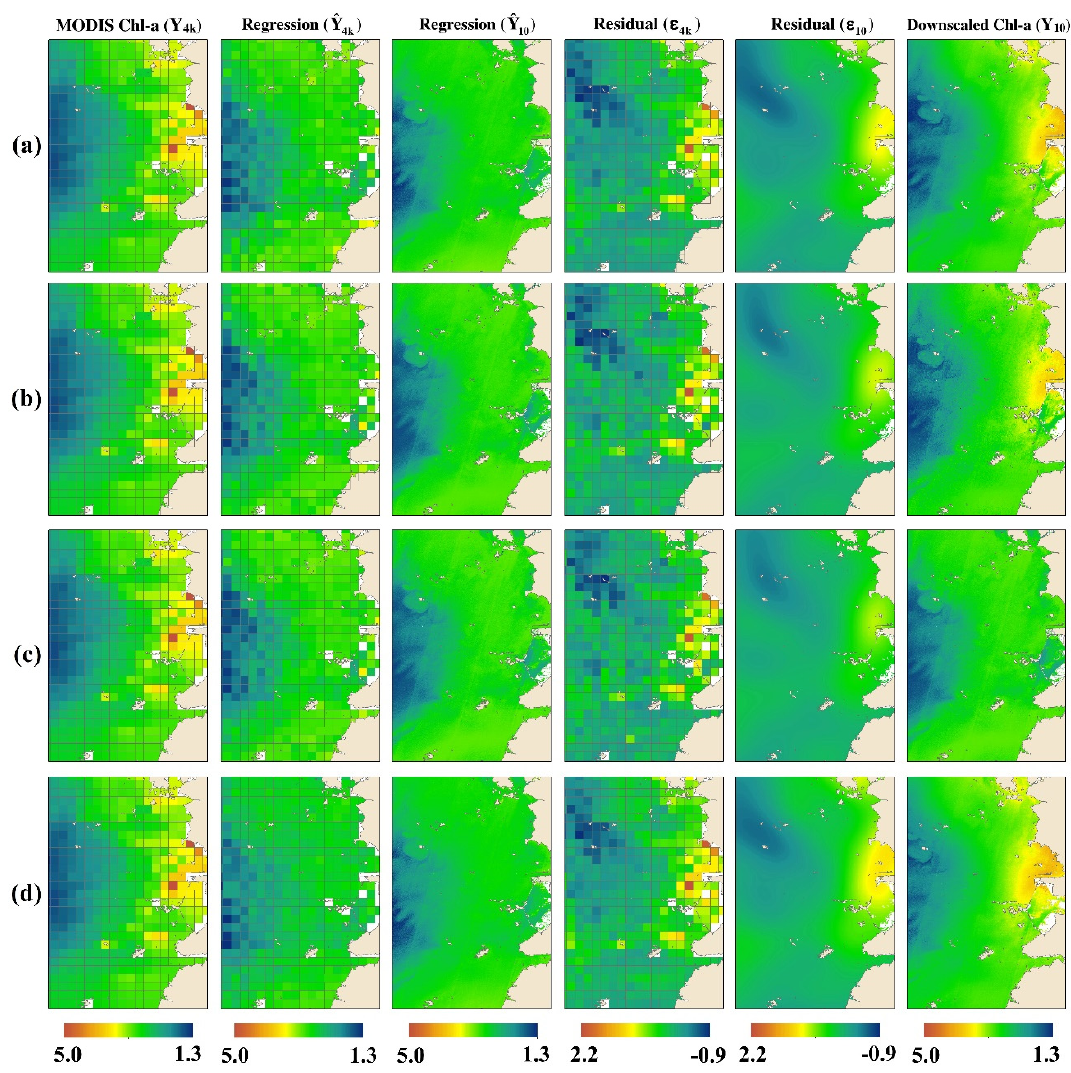
Figure 6. Detailed maps showing the downscaling steps for all models on the winter day